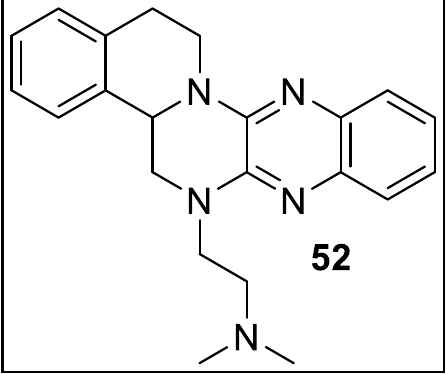
Figure 56. Chemical structure of TNBG-5602.